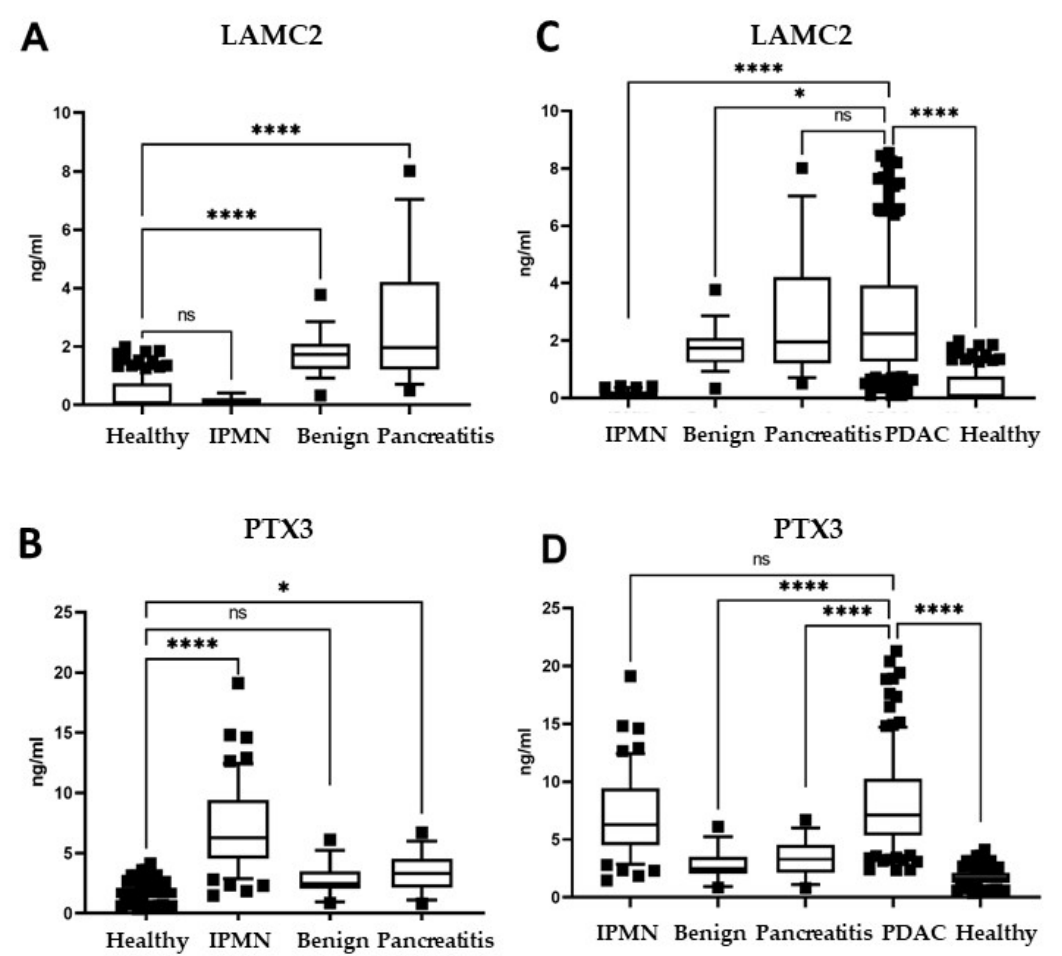
Figure 6. Biomarker panel expression in plasma of patients with non-malignant pancreatic pathologies. ( A , B ) Plasma levels of LAMC2 and PTX3 obtained by ELISA in patients with benign pancreatic tumors (cystadenoma, n = 21), chronic pancreatitis undergoing surgery ( n = 15), or Intraductal Papillary Mucinous Neoplasms (IPMN, n = 52), relative to healthy individuals ( n = 135). ( C , D ) Plasma levels of LAMC2 and PTX3 in non-malignant pancreatic patients relative to patients with PDAC ( n = 200). Statistical analysis ( A , C , D ): one-way ANOVA; ( B ) Student’s t-test with Welch’s correction, outliers eliminated with «Identify outliers» ROUT, * p < 0.05, **** p < 0.0001. Boxes correspond to values comprised between 10 and 90 percentiles.